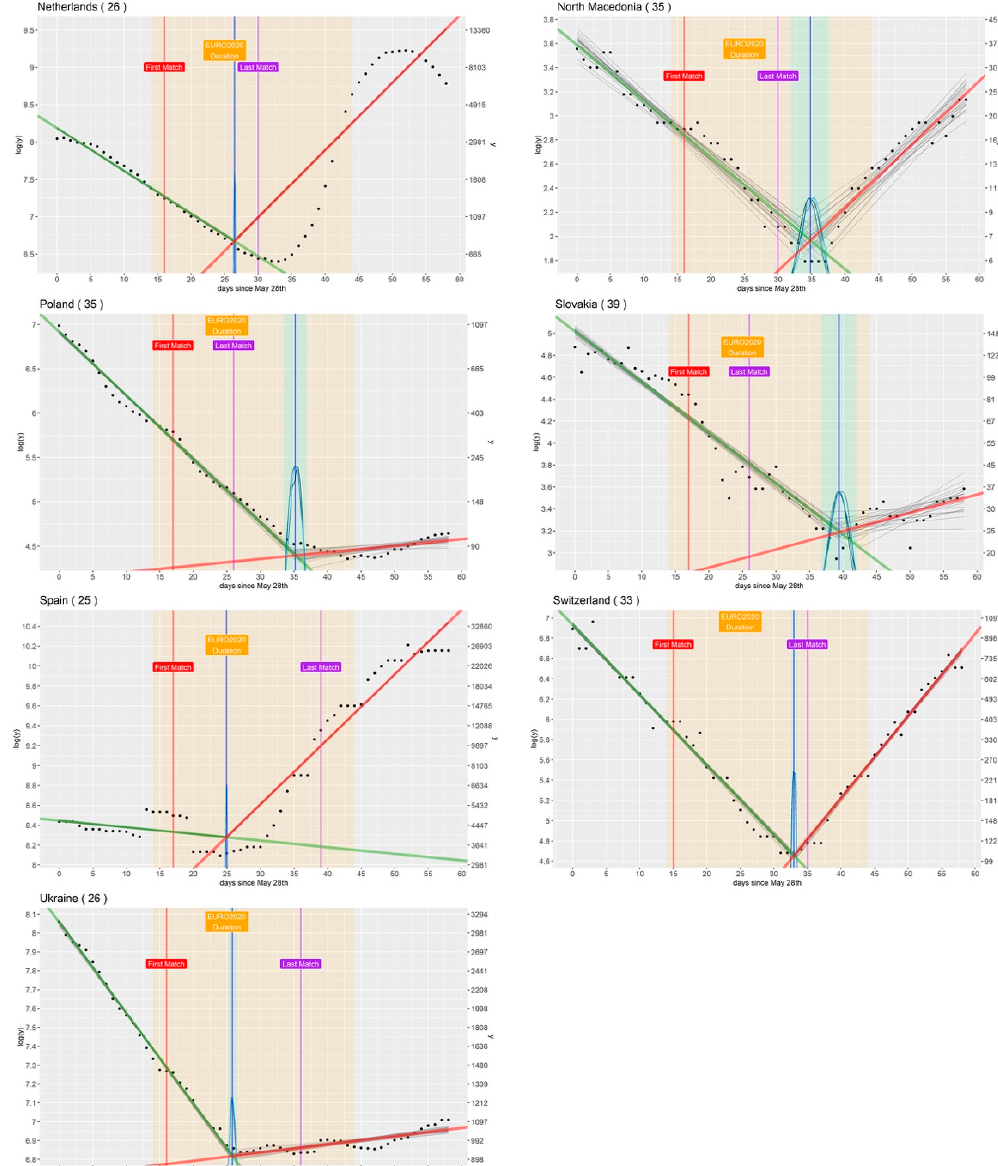
CI. Black dots: number of daily CARS-COV-2 cases. Rightmost y axis: number of cases. Leftmost y axis: logarithm of the number of cases.